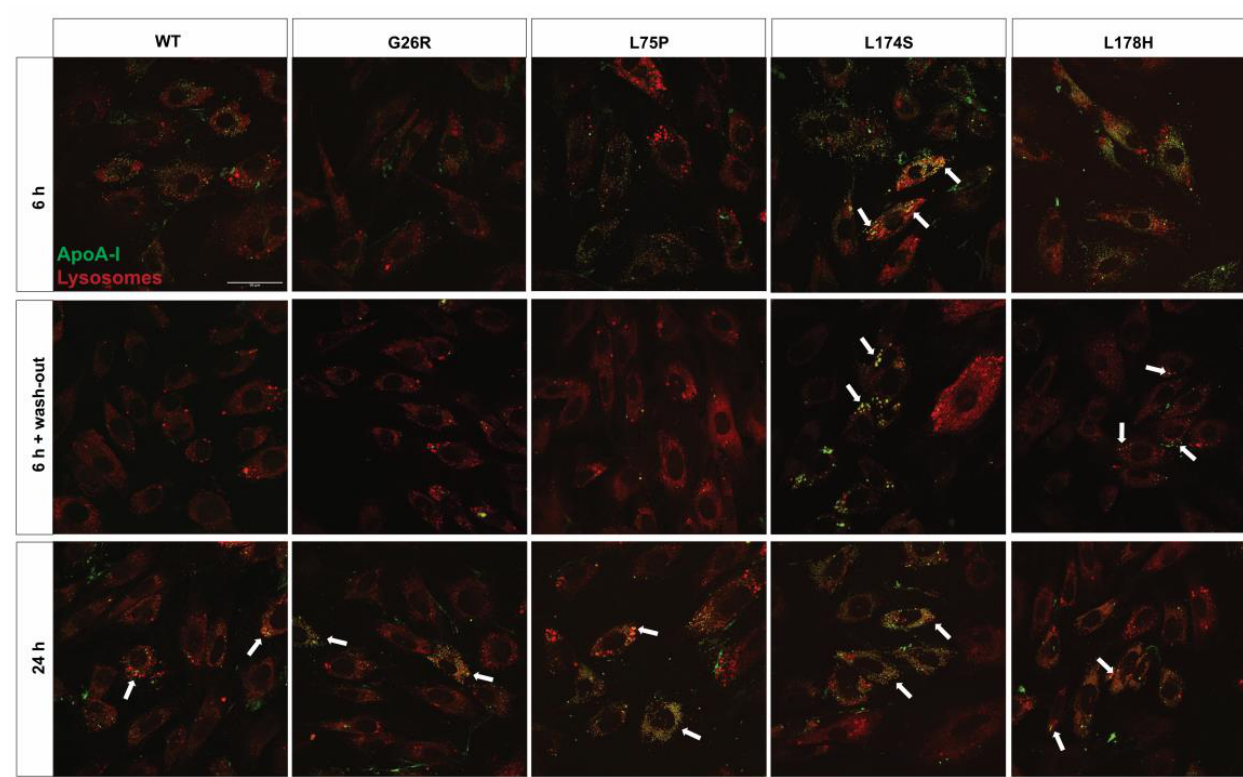
Figure 2. Cellular localization of ApoA-I amyloidogenic variants in H9c2 cardiomyoblasts. H9c2 cells were incubated at 37 °C with 2 µM FITC-labelled ApoA-I proteins (green) for 6 h (upper and middle panels) or 24 h (lower panels). To study the ability of the lysosomes to degrade the ApoA-I proteins, cells incubated with FITC-ApoA-I for 6 h were incubated for additional 16 h in absence of the labelled protein (6 h + wash-out, middle panel). Lysosomes were stained with Lysotracker red. Cells were imaged by confocal microscopy using a 60× objective. Scale bar is 50 μ m. White arrows indicate protein co-compartmentalization with the lysosomes.